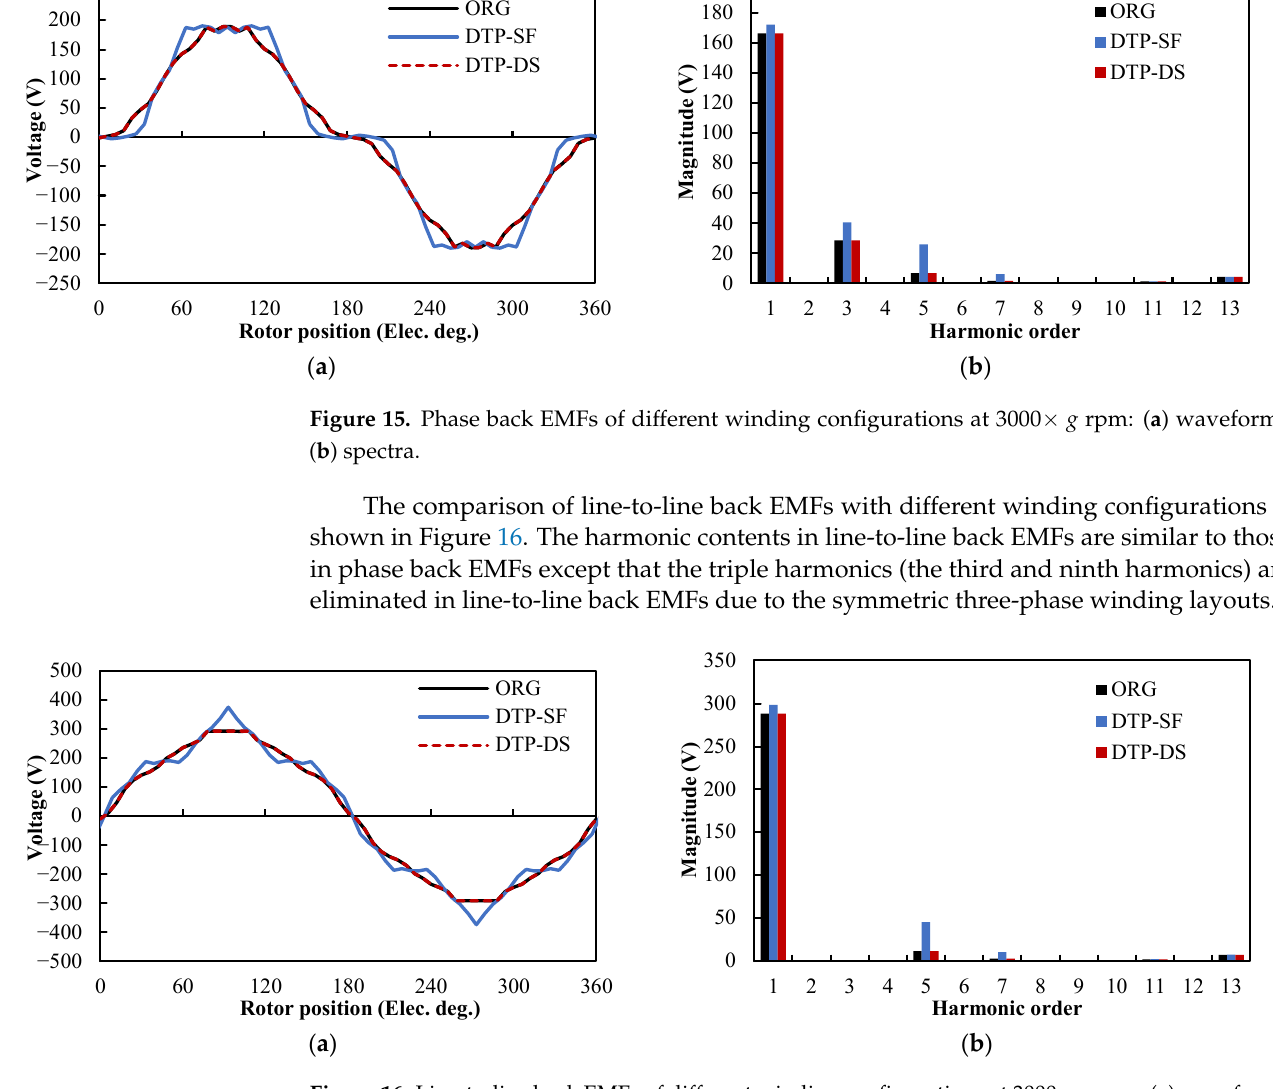
Figure 16. Line-to-line back EMFs of different winding configurations at 3000× g rpm: ( a ) wave- forms; ( b ) spectra.